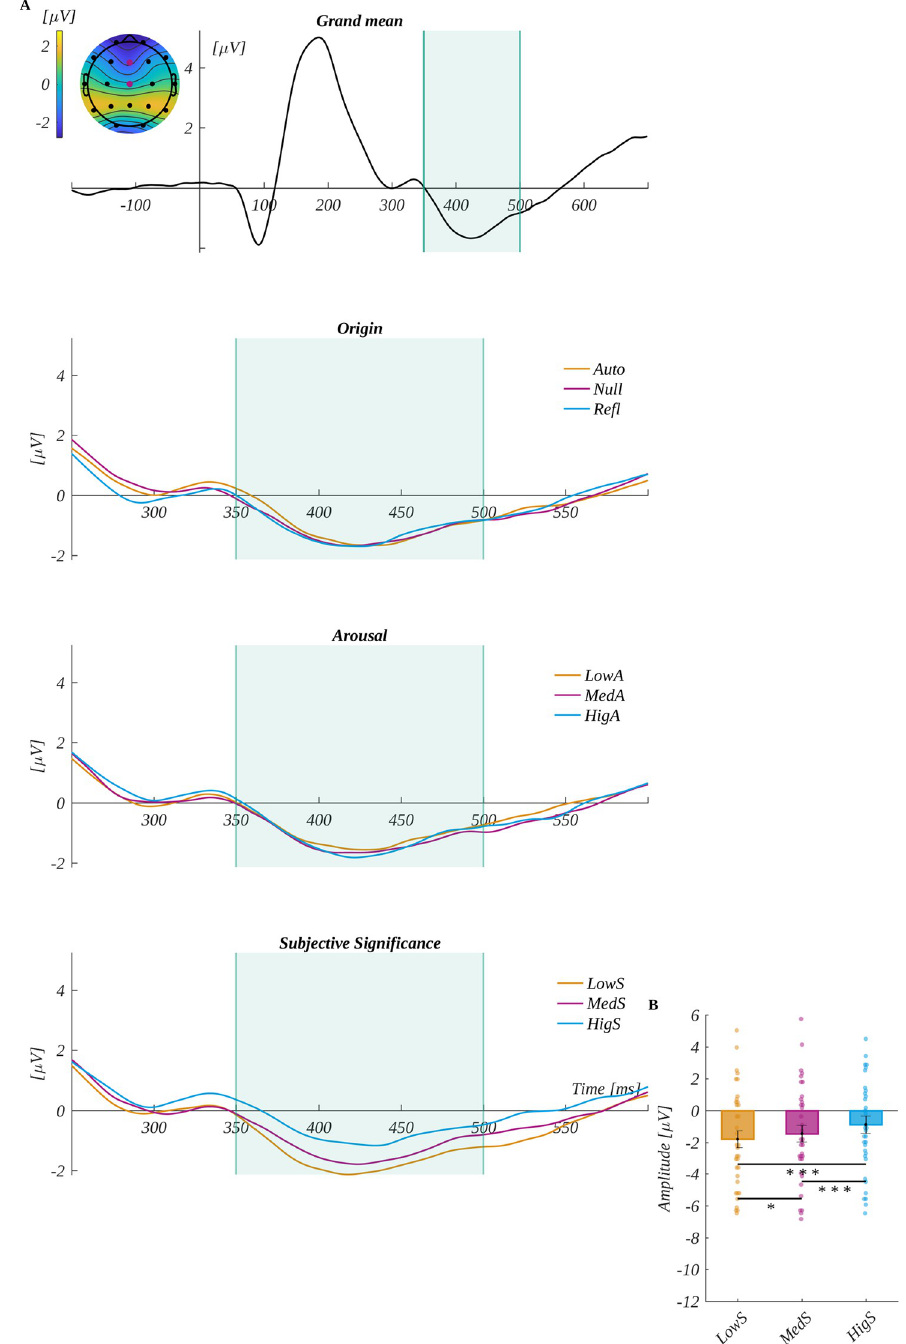
Fig 6. The N450 component results. The upper plot A is the grand average across electrodes from ROI N450 . The marked time-interval was selected for the N450 analysis. The insert shows the topography of the mean potential from this period with the electrodes forming the ROI N450 marked with pink dots. The three bottom plots are the time courses of ERP averaged across electrodes from ROI N450 for each level of origin, arousal and subjective significance. B main effect for subjective significance. The bars represent the mean value, error bars SEM, individual dots mark the average amplitude of an individual subject in the given condition, the black horizontal lines indicate pairs of conditions with significantly different means ( � p < .05, �� p < .01, ��� p < .001).